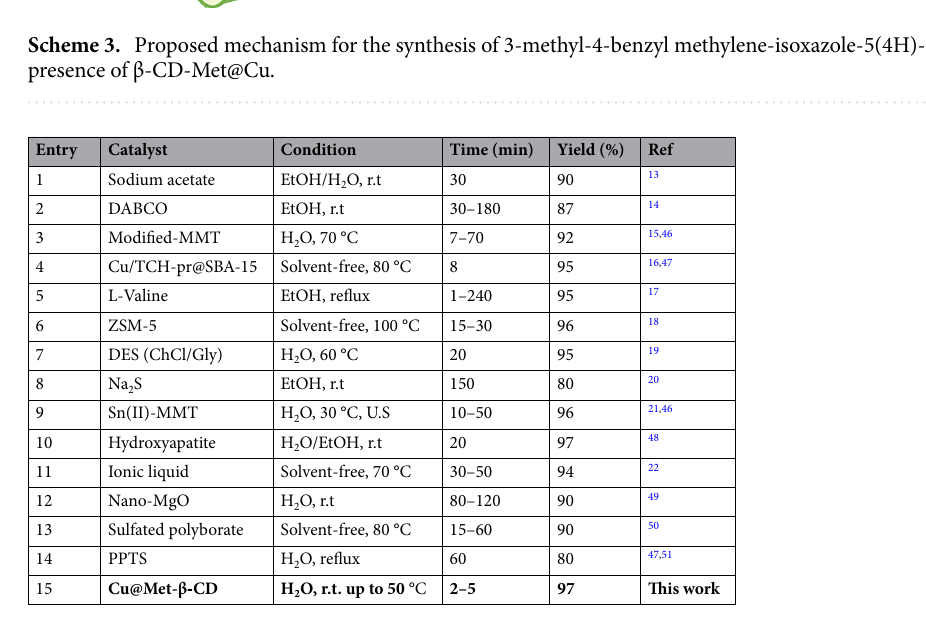
Table 4. Comparison of Cu@Met-β ‐ CD and various catalysts in the synthesis of 4-(4-hydroxybenzylidene)-3- methylisoxazol-5(4H)-one. Significant values are in